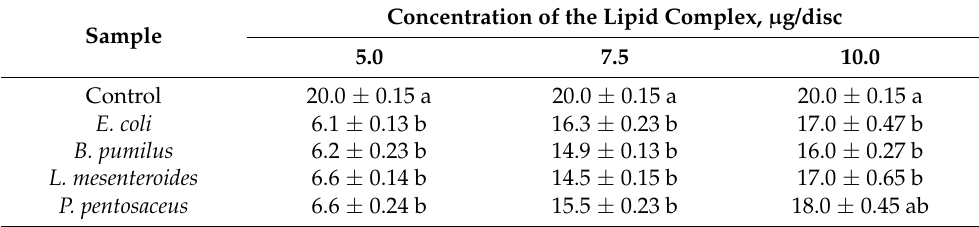
Table 4. Antimicrobial activity (zone of inhibition, mm) of the C. vulgaris lipid complex.